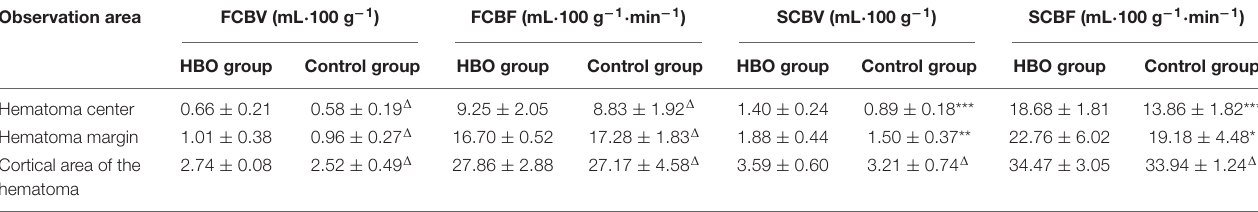
TABLE 2 | Comparison of perfusion parameters in the central, marginal and cortical areas of the hematoma. Observation area